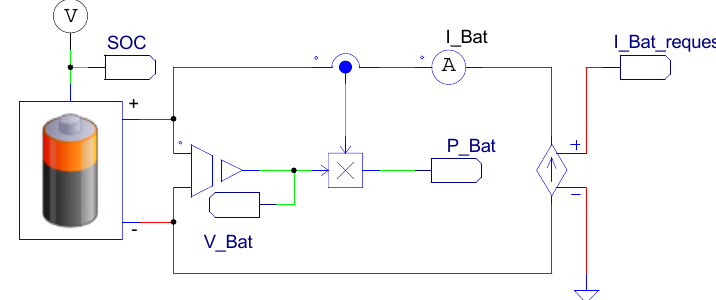
Figure 15. Arrangement of the PSIM battery model.